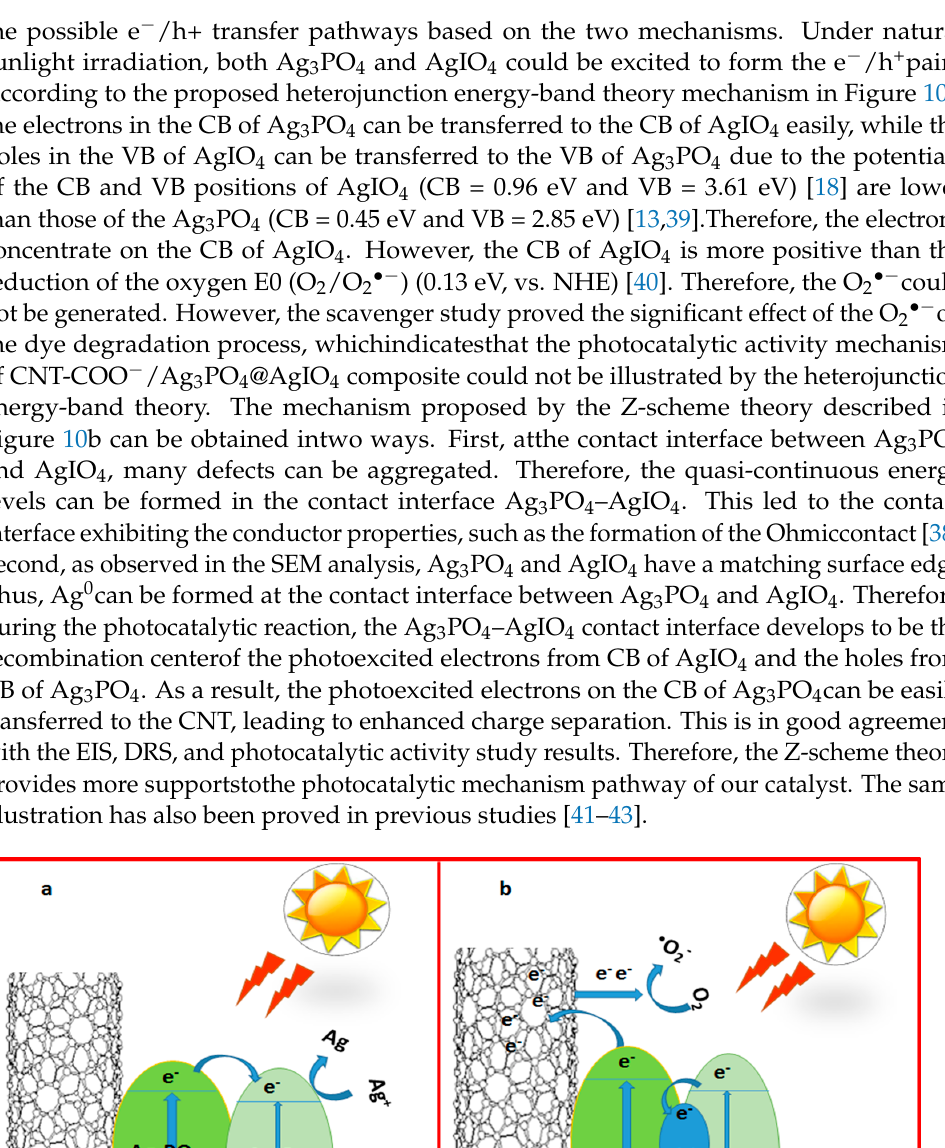
Figure 4. ( a ) DRS spectra of the synthesized materials, and ( b ) the plot of ( α h ʋ ) 2 versus energy (h ʋ ). 2.2.5. Electrochemical Impedance Spectroscopy The electron–hole recombination resistance and the charge transfer ability ofthe synthesized photocatalysts were measured using electrochemical impedance spectros- copy (EIS). As shown in Figure 5, the diameters of the arc followed the order CNT-COO − /Ag 3 PO 4 @AgIO 4 <CNT-Ag 3 PO 4 @AgIO 4 < Ag 3 PO 4 @AgIO 4 < Ag 3 PO 4 . Therefore, it can be confirmed that CNT-COO − /Ag 3 PO 4 @AgIO 4 exhibited enhanced e − /h + separation and transferability at the catalyst–electrolyte interface compared with the other compo- sites. In addition, the good interaction between the CNT-COO and Ag 3 PO 4 in the CNT-COO/Ag 3 PO 4 @AgIO 4 composite further enhanced the electron transfer over the CNT-Ag 3 PO 4 @AgIO 4 , which was due to the interfacial bonding between the CNT-COO